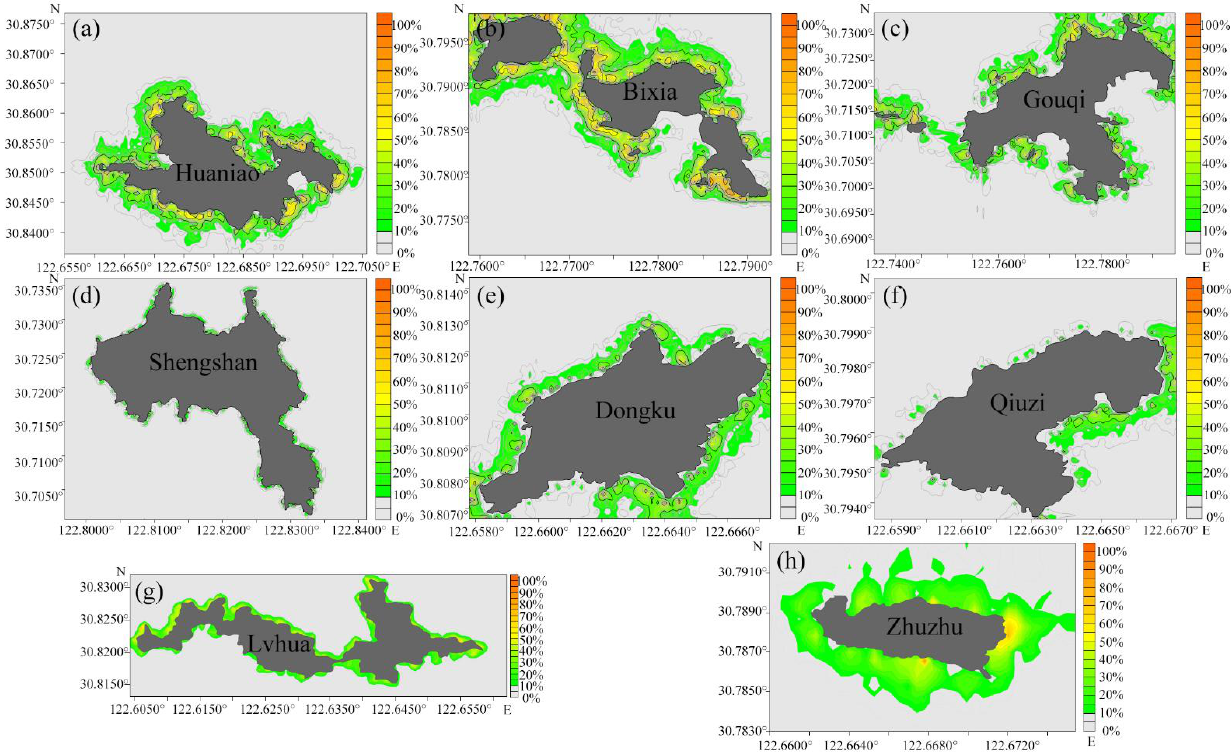
Figure 4. Coverage distributions of seaweed in the Ma ’ an Archipelago. ( a ) HN (Huaniao), ( b ) BX (Bixia), ( c ) GQ (Gouqi), ( d ) SS (Shengshan), ( e ) DK (Dongku), ( f ) QZ (Qiuzi), ( g ) LH (Lvhua), and ( h ) ZZ (Zhuzhu).